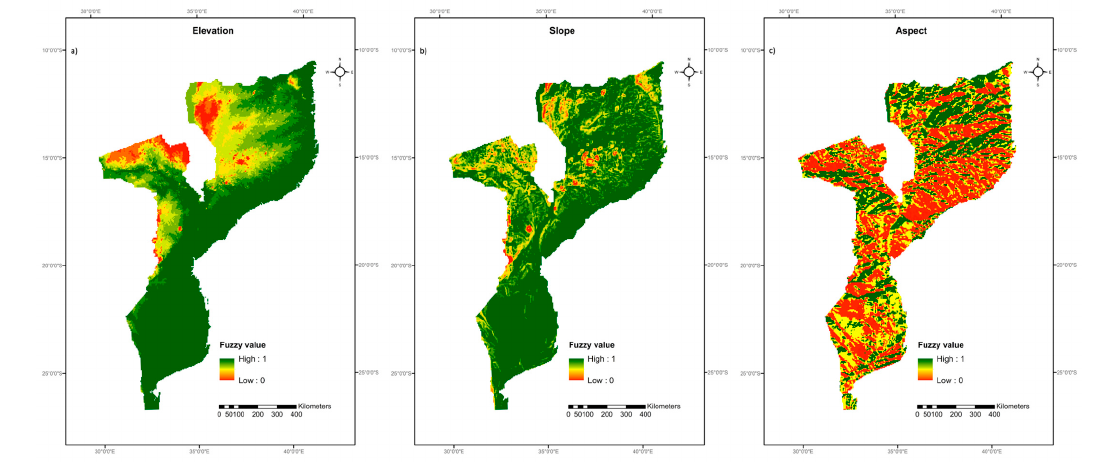
Figure A4. Standardized (reclassified and fuzzified) raster maps of orography criteria applied to the spatial suitability of off-grid solar PV microgrid projects in Mozambique. ( a ) Elevation, ( b ) slope, and ( c ) aspect.